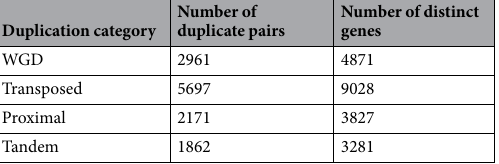
Table 1. Studied duplicate genes in rice originating from different duplication